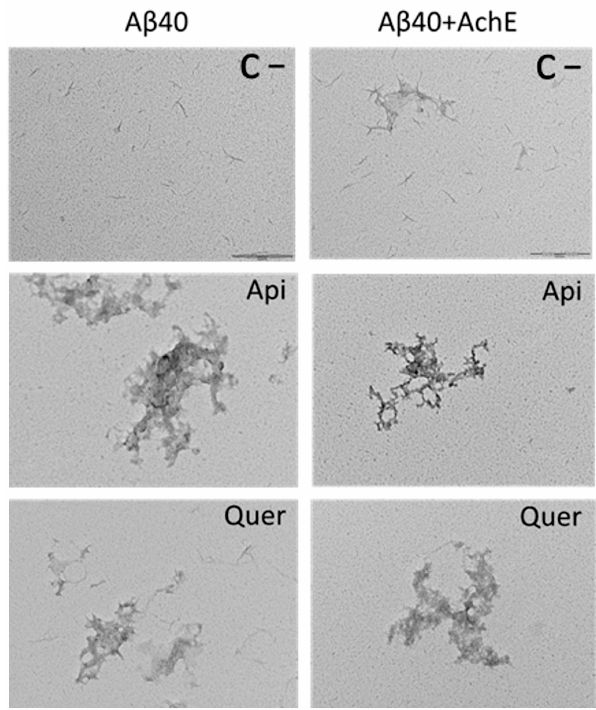
Figure 6. TEM images of A β 40 fibrils generated without ( left ) and with ( right ) AChE, and in the